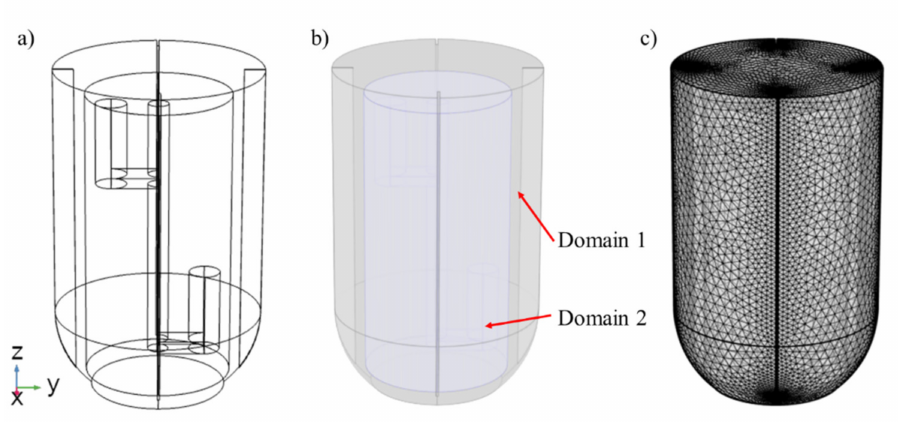
Figure 1. Stirred batch adsorber: ( a ) 3D geometry, ( b ) computational domains in the geometry, ( c ) triangular